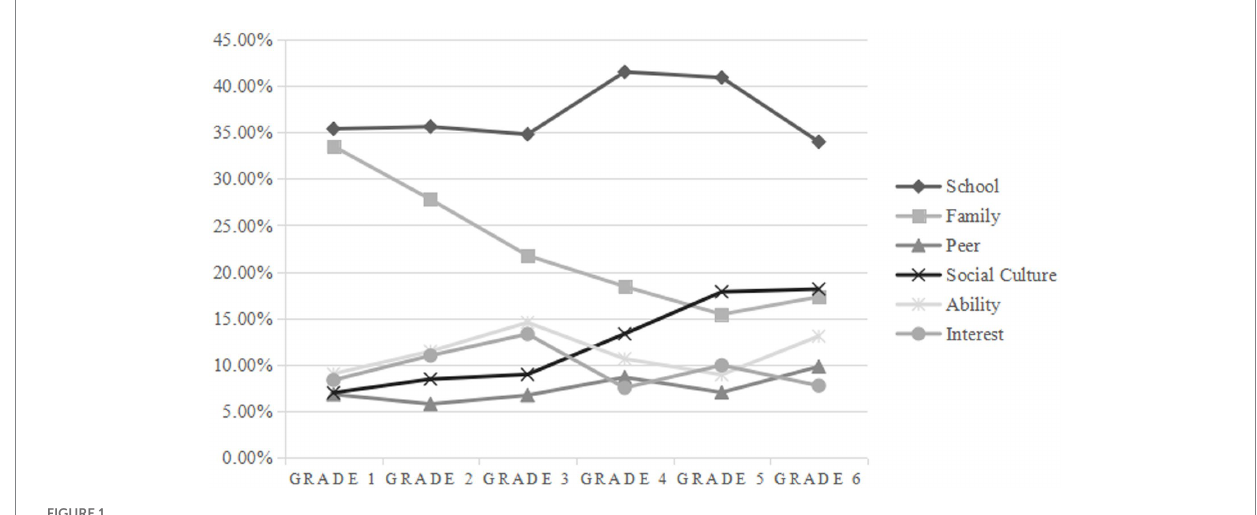
FIGURE 1 The percentage of topic texts with Grade Growth.